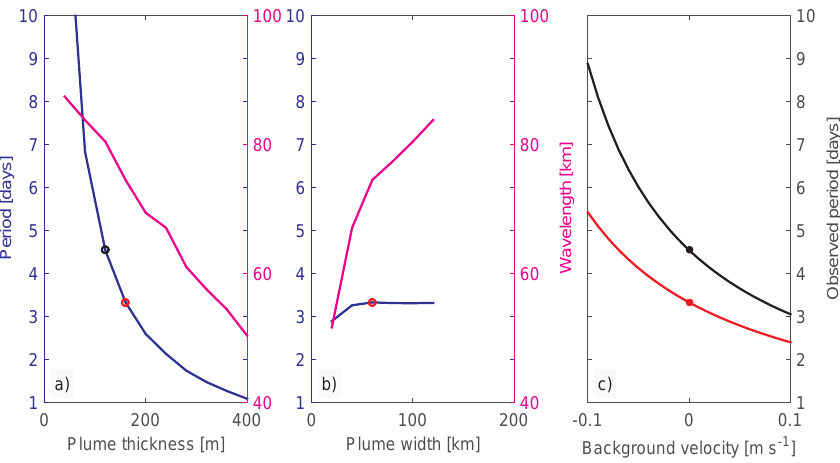
Figure 10. Period (blue) and wavelength (magenta) of the most unstable wave as a function of (a) plume thickness (plume width is 60km) and ( b ) plume width (plume thickness is 160m). (c) Period observed at a stationary mooring as a function of background velocity for an oscillation with an intrinsic period and a wavelength of 3.33/4.5 days and 75/80km (red/black line). The corresponding period–wavelength pairs are marked with circles in the same colour in (a–b)